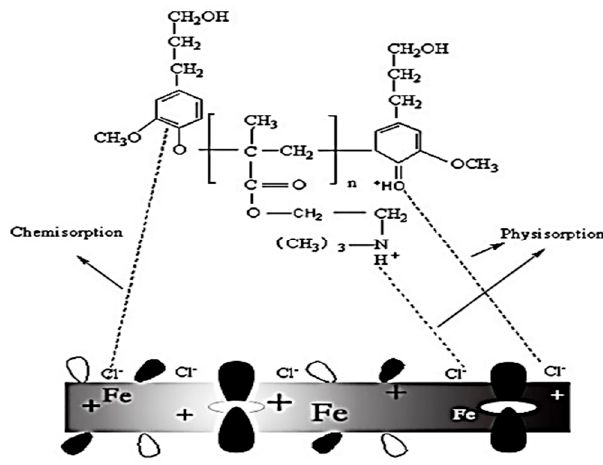
Figure 9. Schematic representation of lignin-DMC with the metal surface in 1 mol/L